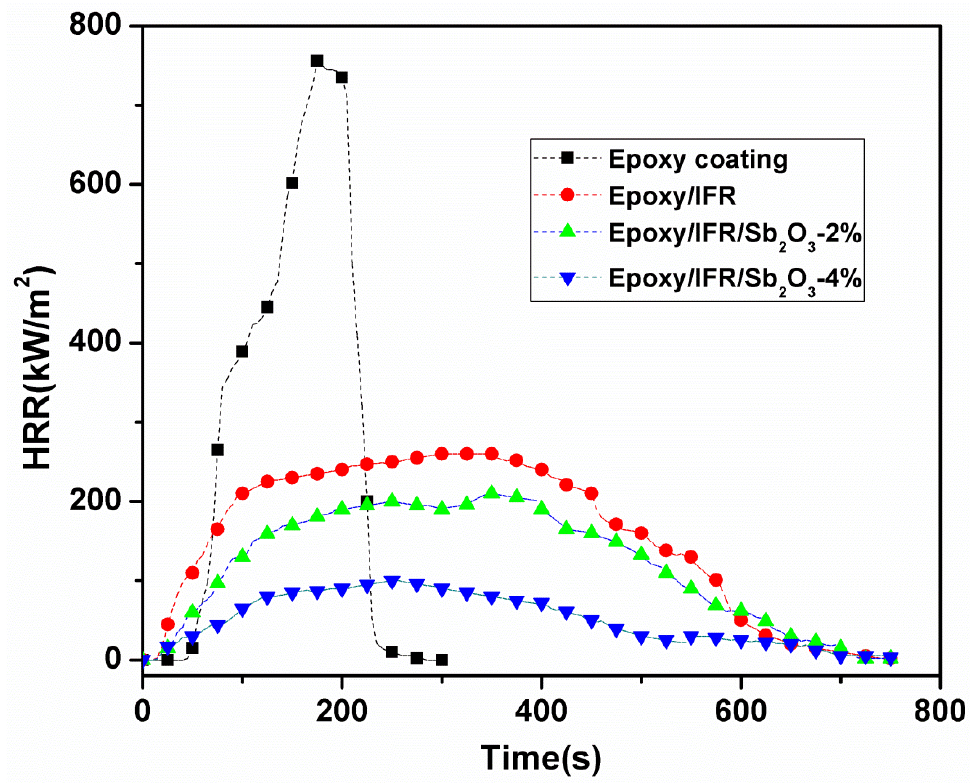
Figure 10. Peak heat release rate (PHRR) curves of coatings